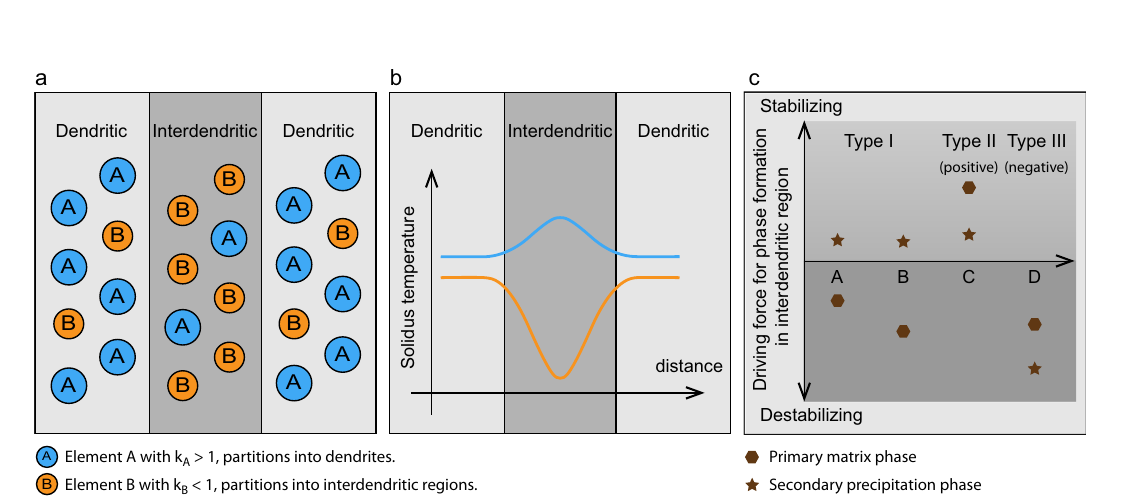
solidus temperature changes when the partitioning behavior of only one element (e.g., B, Ti, Si, and C) is considered for the 0.11Si sample. c The equilibrium B concentration within the γ phase and its partition coef fi cient for the 0.11Si sample at 1200°C. d Derivatives of driving forces for the γ and MC carbide phases inside the interdendritic region of 0.11Si sample at 1100°C.